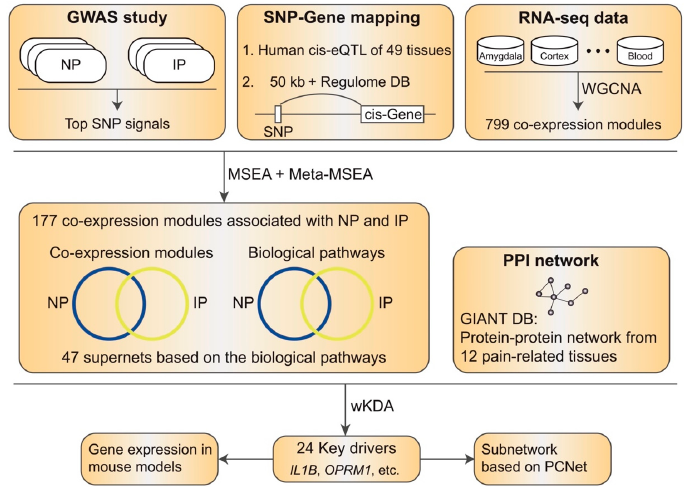
Figure 1. Study schema. We integrated the genetics and functional genomics datasets to identify NP- and IP-associated co-expression modules. Briefly, GWASs of NP and IP were obtained from public databases. A comprehensive list of tissue-specific functional genomic datasets was compiled, including 799 co-expressed modules and SNP-to-gene association. MSEA and meta-MSEA were performed to identify significantly overrepresented modules. The significant modules were annotated to reveal the common pathways of NP and IP. Using the modules, we constructed 47 supernets based on the shared biological processes. We then carried out wKDA to identify the conservative key drivers by integrating protein interaction networks from multiple pain-related tissues. The final KDs were mapped to PCNet to build a one-edge subnetwork and checked with the gene expression regulations in mouse models of neuropathic and inflammatory pain.